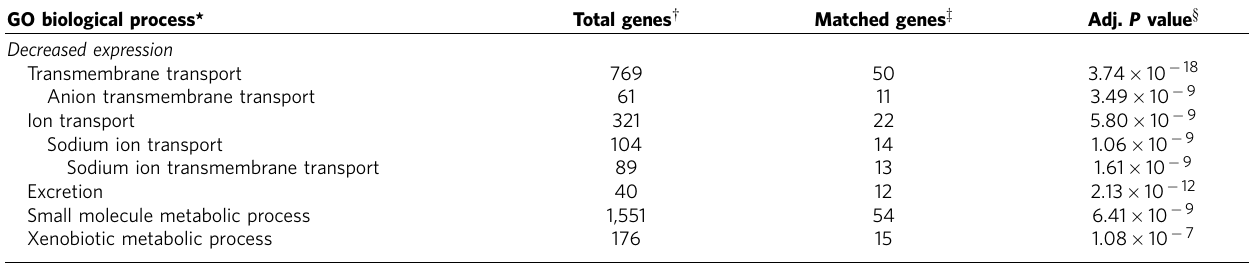
Table 1 | Network analysis of top DEGs in